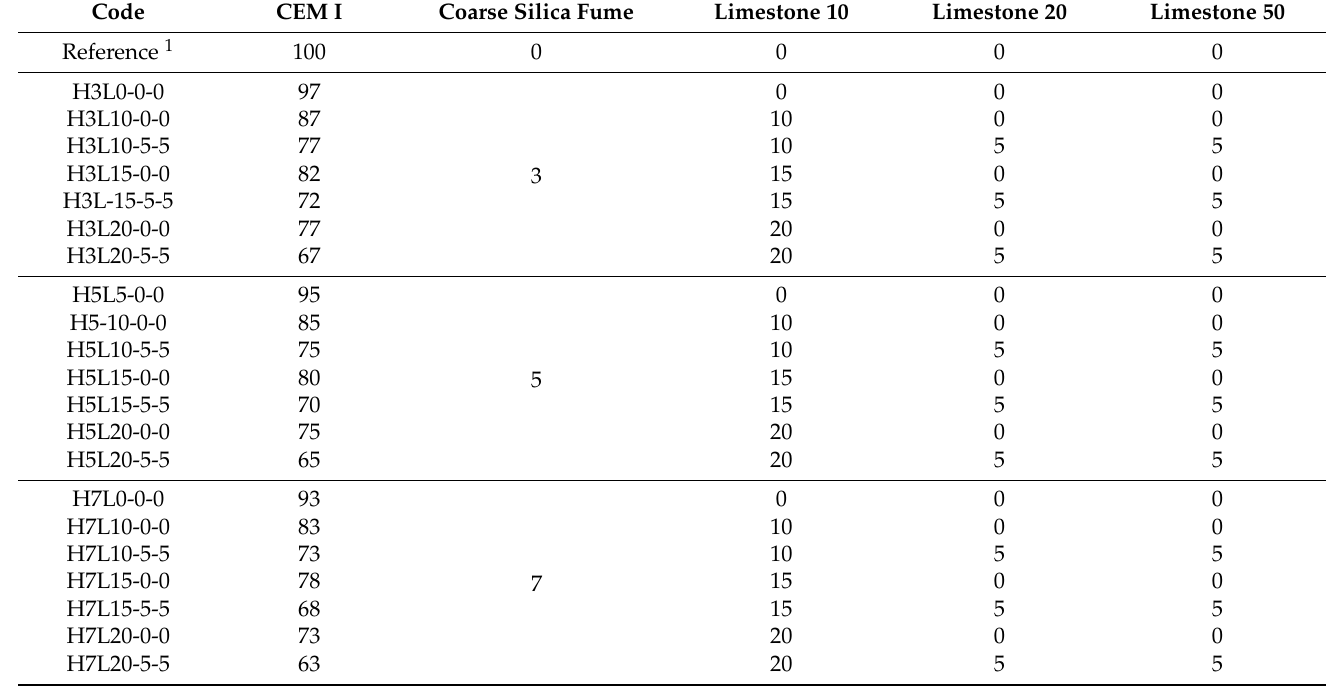
Table 4. Raw materials and mix design to manufacture ternary cements,